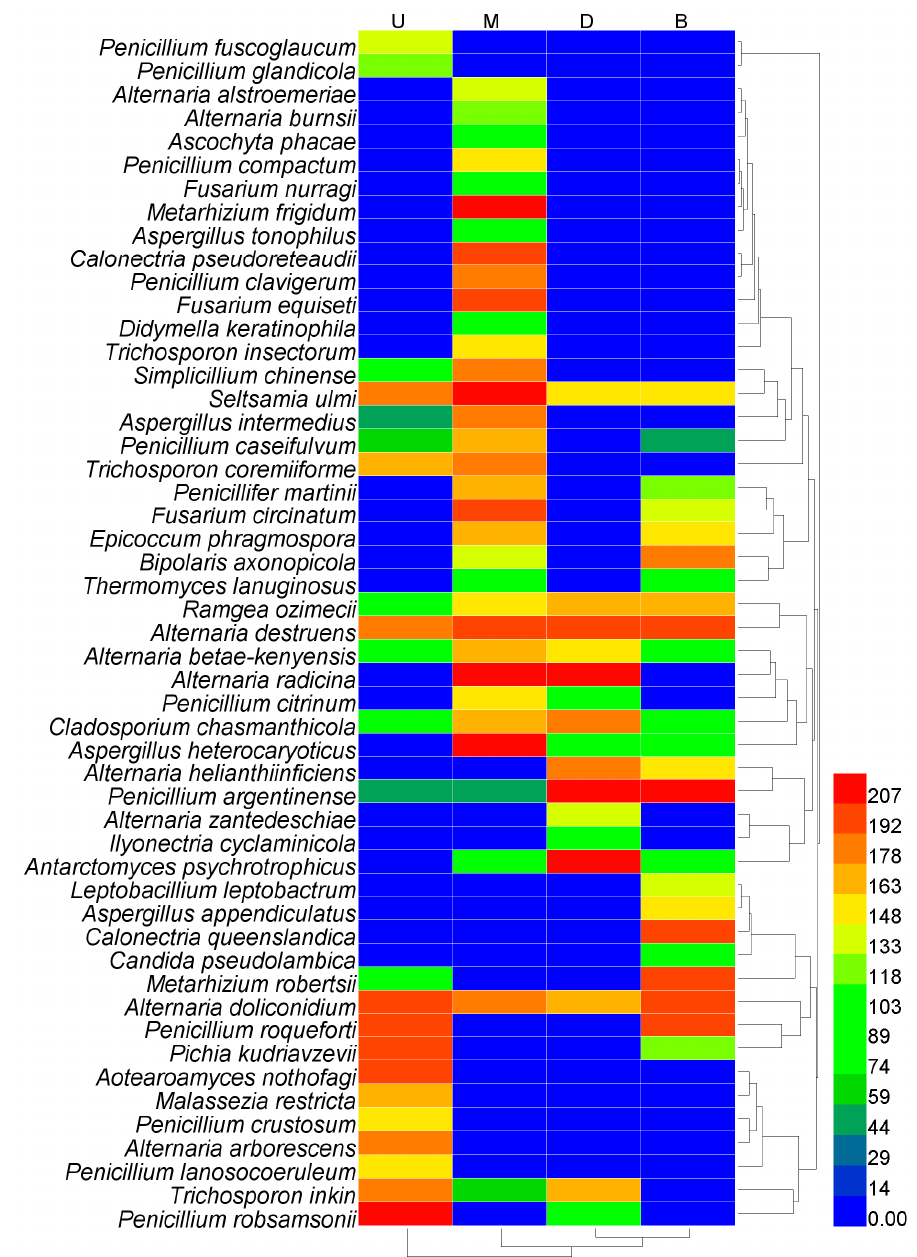
Figure 4. Heatmap of fungal communities in the pit mud samples from different spatial positions of the cellar. Lanes U, M, D, and B respectively represent pit mud samples collected from up wall layer of cellar, middle wall layer of cellar, down wall layer of cellar, and bottom layer of cellar, and were sampled from the same fermentation cellar. The scale bar shows the abundance of the genera, red and blue represents high and low abundance, respectively. The tree diagram shows the cluster analysis results of different fungal communities from different spatial positions in the cellar.